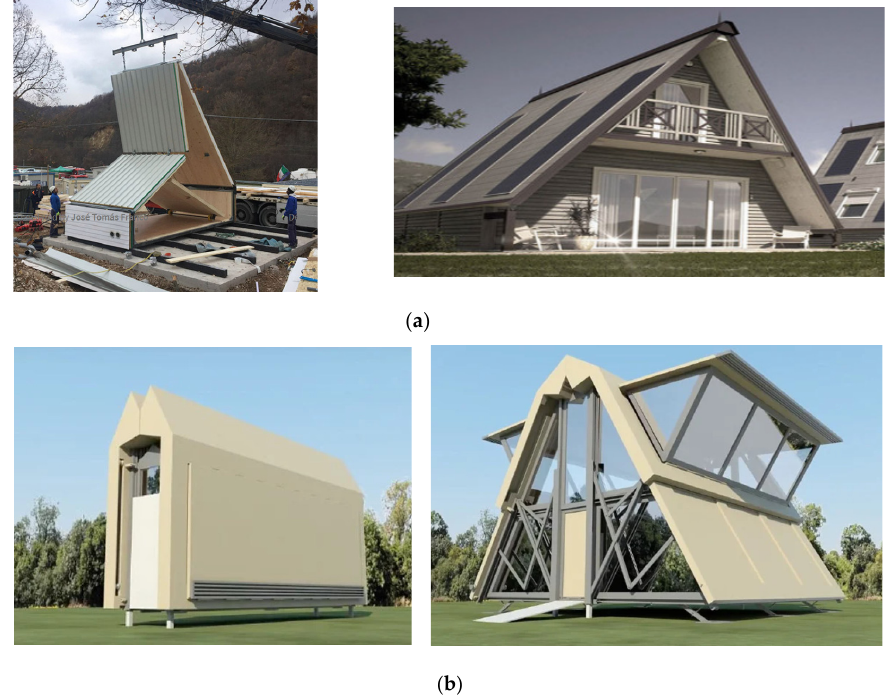
Figure 4. Deployable structures. ( a ) Deployable house by M.A.D.I [111]. ( b ) Deployable house by Ten Fold Engineering